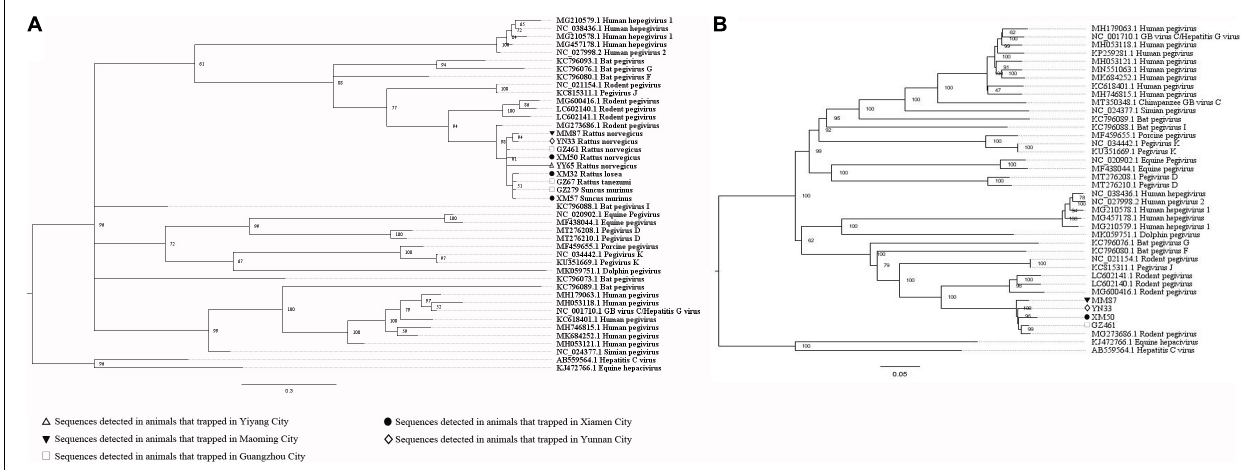
FIGURE 9 | (A) Phylogenetic tree constructed based on PCR-screened nucleotide sequences (183 bp) of pegivirus from urban rats and house shrews (MrBayes, GTR + G + I nucleotide substitution model). A total of 33 representative pegivirus sequences of different species within genus Pegivirus and two sequences belonging to genus Hepacivirus (set as outgroup) are included for comparison (polyprotein gene region). Percentages of the posterior probability (PP) values are indicated. (B) Phylogenetic tree constructed based on near full-length nucleotide sequences (9912 bp) of pegivirus from R. norvegicus (MrBayes, GTR + G + I nucleotide substitution model). A total of 34 representative pegivirus sequences of different species within genus Pegivirus and two sequences belonging to genus Hepacivirus (set as outgroup) are included for comparison. Percentages of the posterior probability (PP) values are